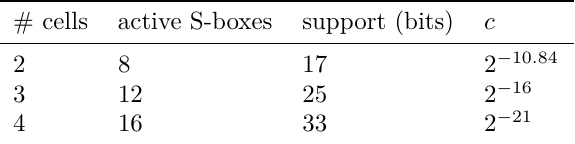
Table 2: The number of active S-boxes, the number of bits observed by a probe, and a bound on c , the square correlation times the support of the observation, over two rounds of the masked Prince given how many cells are activated by a